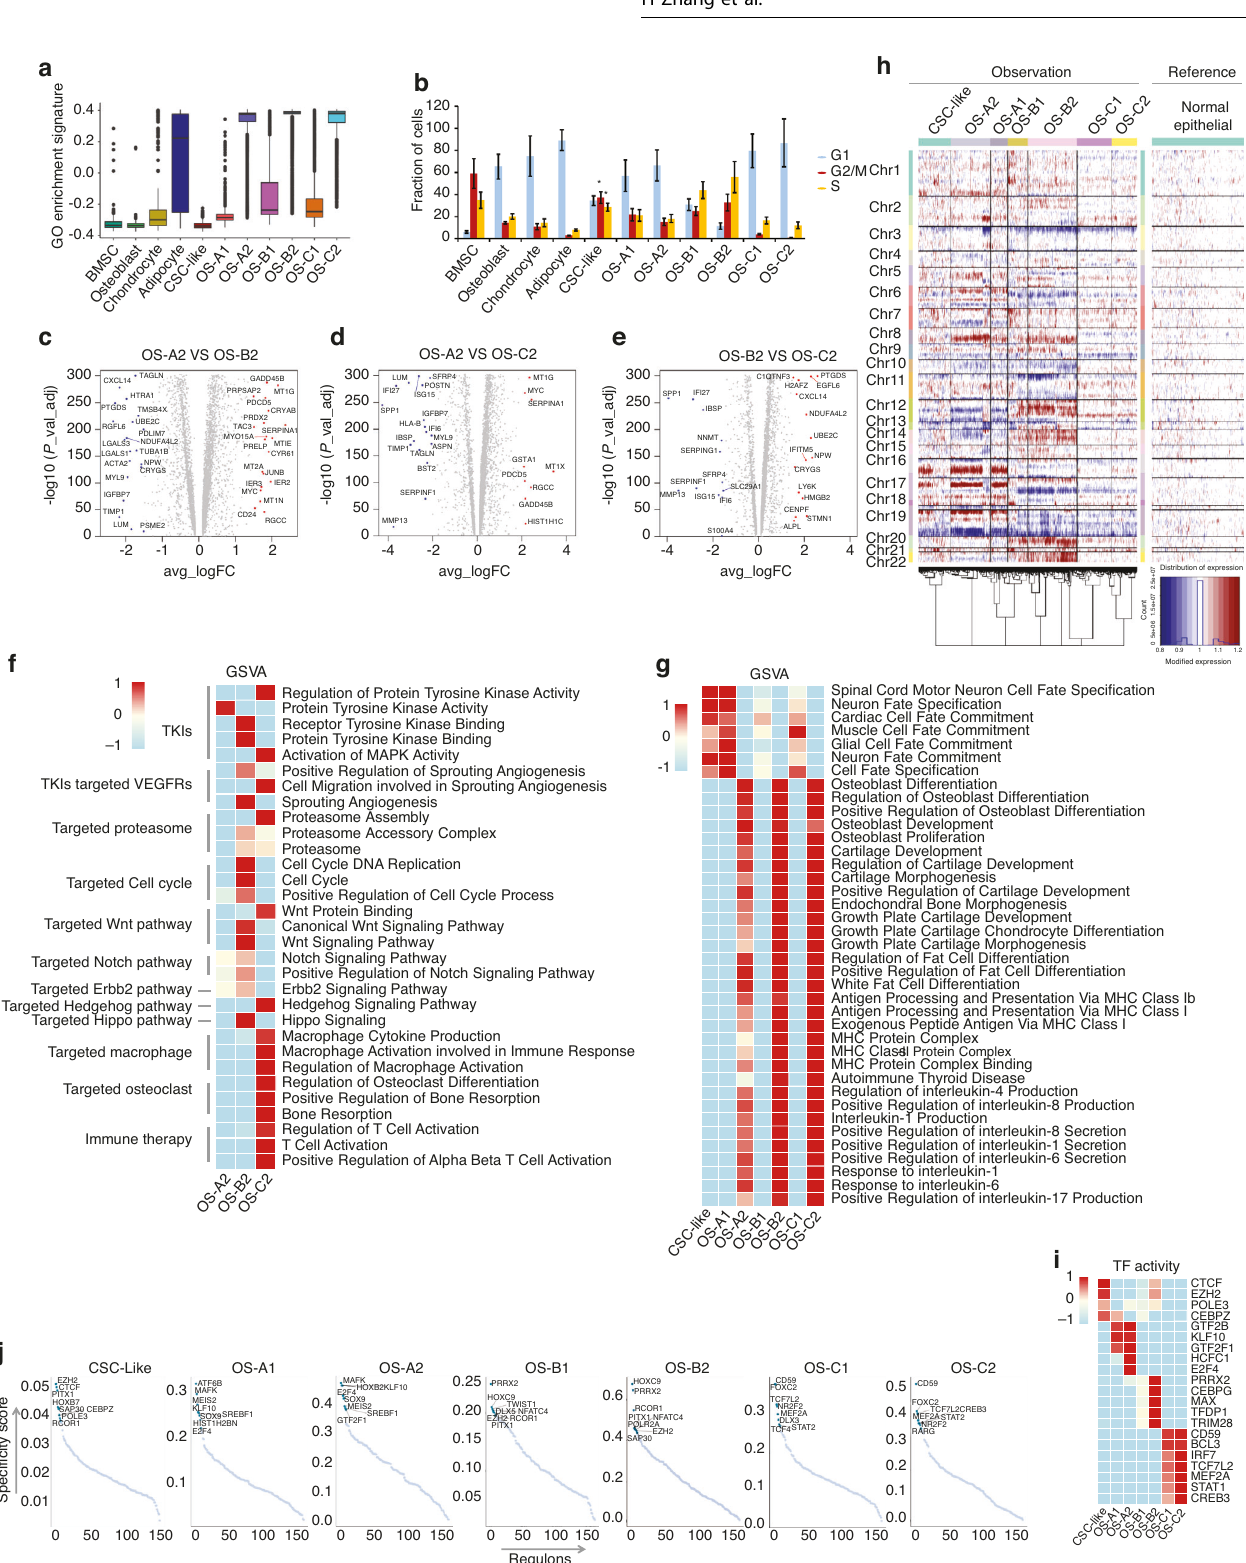
Fig. 3 Transcriptional distinction between the three differentiation trajectories of OS cells. a Differences in total GO pathway enrichment between the seven OS clusters. b Differences in the proportion of cell cycle phases in the 11 mesenchymal clusters. c Differences in gene expression between the OS-A2 and OS-B2 clusters. d Differences in gene expression between the OS-A2 and OS-C2 clusters. e Differences in expression between the OS-B2 and OS-C2 clusters. f Heatmap showing differences in the activation of pathways related to targeted therapies in OS-A2/B2/C2 clusters calculated by the GSVA method. g Heatmap showing differences in activation of pathways between the seven OS clusters. h Heatmaps of differences in single-cell copy number between the seven OS clusters and normal endovascular cells. i Heatmap showing differences in TFactivity between the seven OS clusters. j TFactivity in the seven OS clusters. The top 8 activated TFs were marked in each